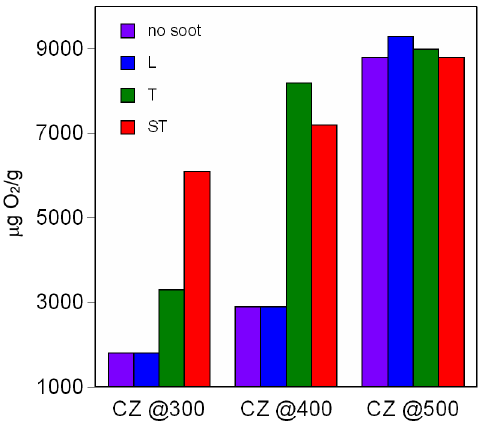
Figure 3. Oxygen storage capacity (OSC) results from thermal gravimetric analysis (TGA) analysis for di ff erent contact